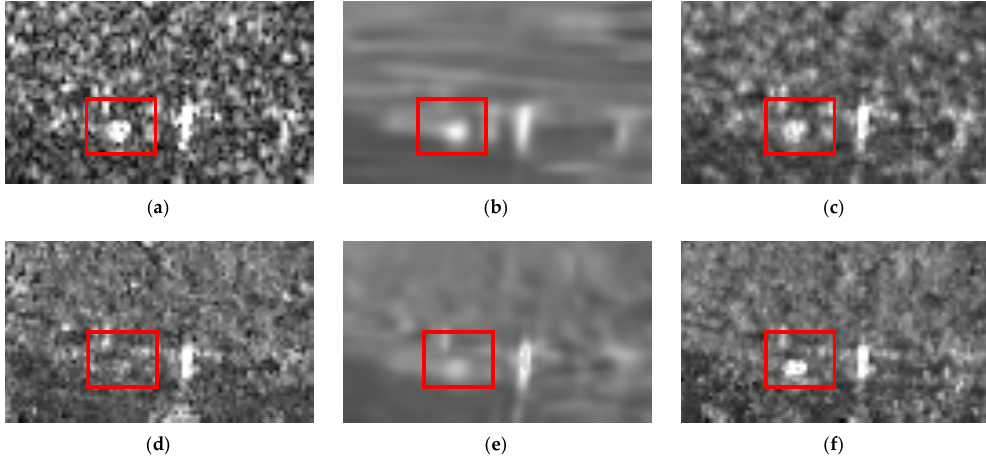
Figure 12. Preservation of strong target points for Dataset 2. ( a ) Original image (28 March 2012); ( b ) FANS; ( c ) QF; ( d ) CDMF; ( e ) MSAR_BM3D; ( f ) the proposed approach.